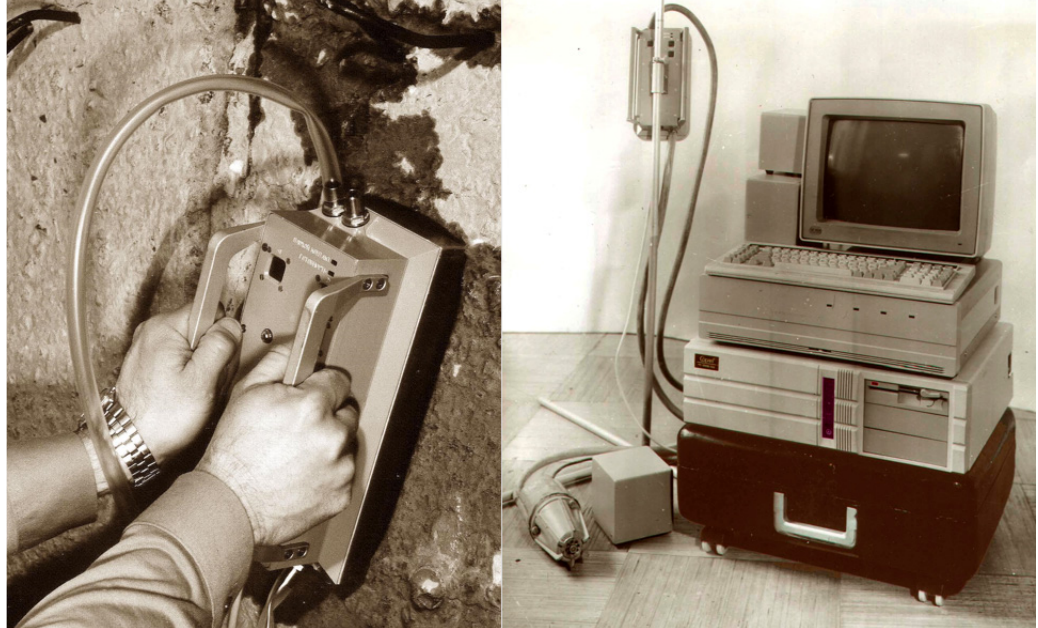
Figure 1. Preliminary transducer array with liquid contact (courtesy of ACS Group).